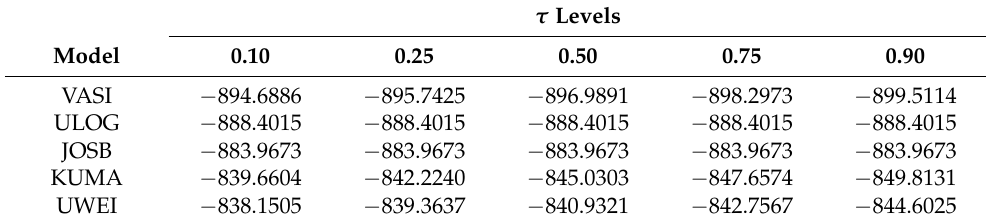
Figure 4. QQ plots with simulated envelopes of Cox–Snell (first row) and normalized quantile (second row) residuals for the listed τ quantile with fat proportion in the arms. Table 8. The Akaike information criterion for the body fat proportion